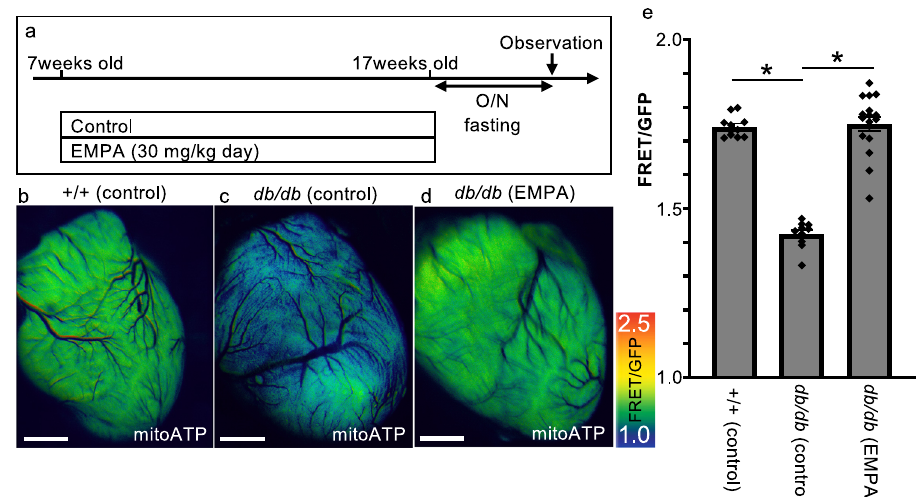
Fig. 3 Chronic treatment with empagli fl ozin reverses mitochondrial ATP loss in the heart of T2D model mice. a Schematic illustration of the treatment regimen (EMPA empagli fl ozin). b – d Representative fl uorescence images of a live heart from each condition (EMPA empagli fl ozin). Warmer colors indicate higher ATP concentrations. Scale bar: 2 mm. e FRET/GFP ratios indicating the mitochondrial ATP level in the heart under each condition ( + / + (control): n = 11, db / db (control): n = 10, db / db (EMPA): n = 17). * p = 10 nM empagli fl ozin, 1.22 ± 0.020 in the group with 100 nM empagli fl ozin, 1.31 ± 0.015 in the group with 500 nM empagli- fl ozin and 1.40 ± 0.013 in the group with 1000 nM empagli fl ozin (Fig. 4e – g, p = 0.0010, 0.0058, 0.0000, 0.0000 vs. db/db control).